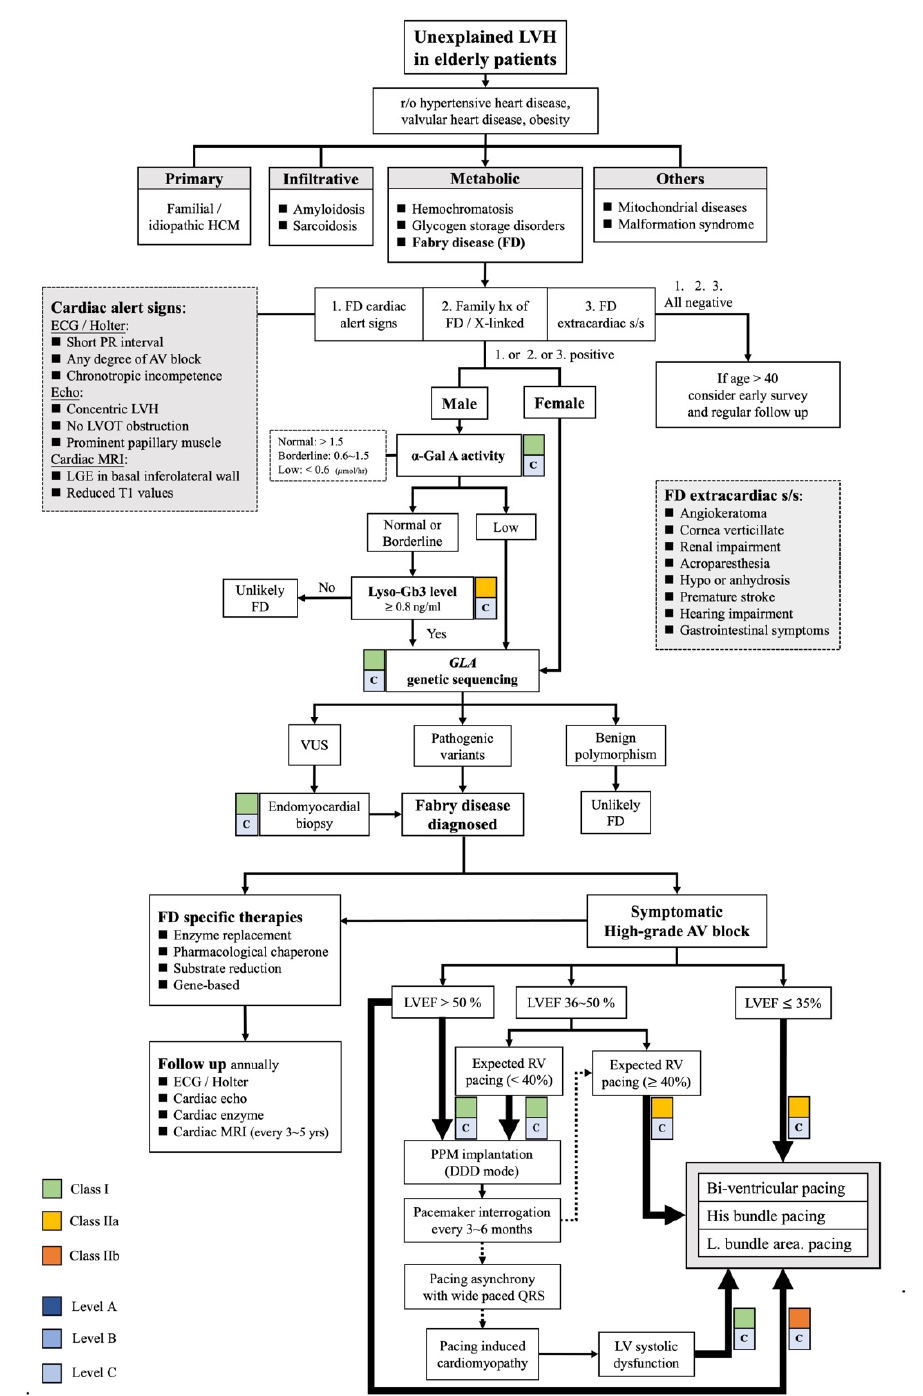
Figure 3. A hypothetical algorithm to evaluate elderly patients who have unexplained LVH to the diagnostic and therapeutic management of FD with high-grade AV block. LVH: left ventricular hypertrophy, r/o: rule out, HCM: hypertrophic cardiomyopathy, FD: Fabry disease, hx: history, LVOT: left ventricular outflow tract, MRI: magnetic resonance imaging, LGE: late gadolinium enhancement, s/s: symptoms/signs, α -Gal A: α -galactosidase A, Lyso-Gb3: globotriaosylsphingosine, GLA : α -galactosidase A gene, VUS: variants of unknown significance, RV: right ventricular, LVEF: left ventricular ejection fraction, PPM: permanent pacemaker, DDD: dual-chamber pacing. Classes I, IIa, IIb: the classes of recommendation based on existing studies or guidelines. Levels A, B, C: the levels of evidence based of existing studies [4,18,20,21].